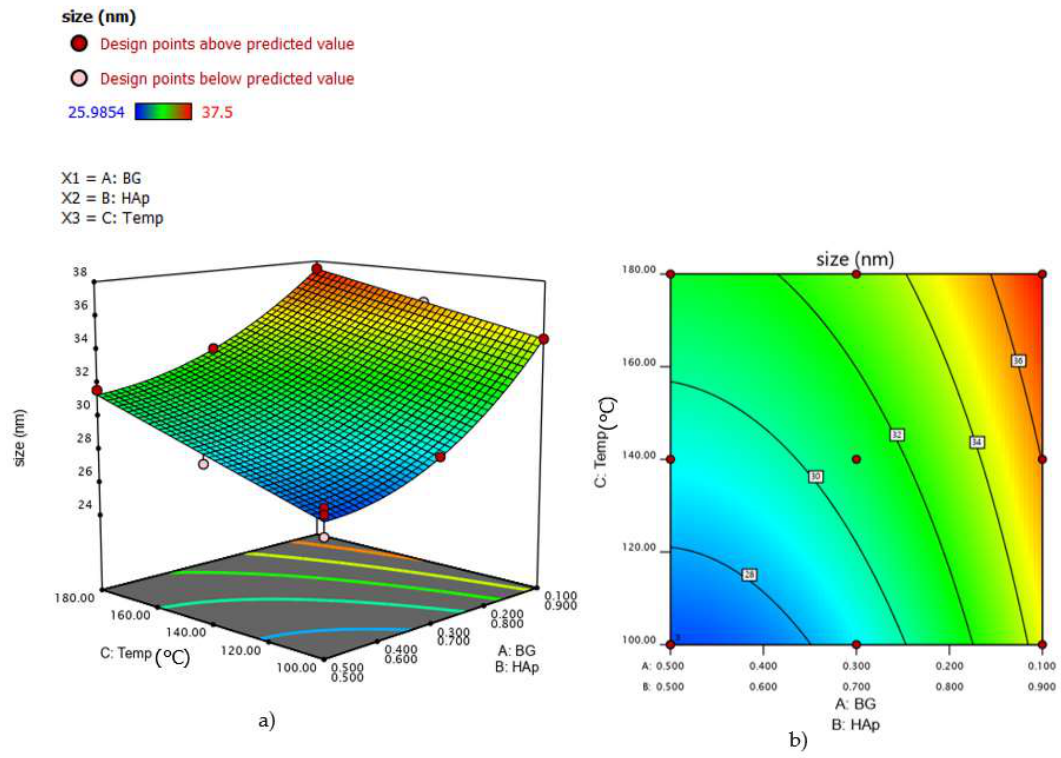
Figure 7. ( a ) 3D mixture–process diagram; ( b ) 2D mixture–process contour plot of process conditions that influence HAp/BG composite crystal size.